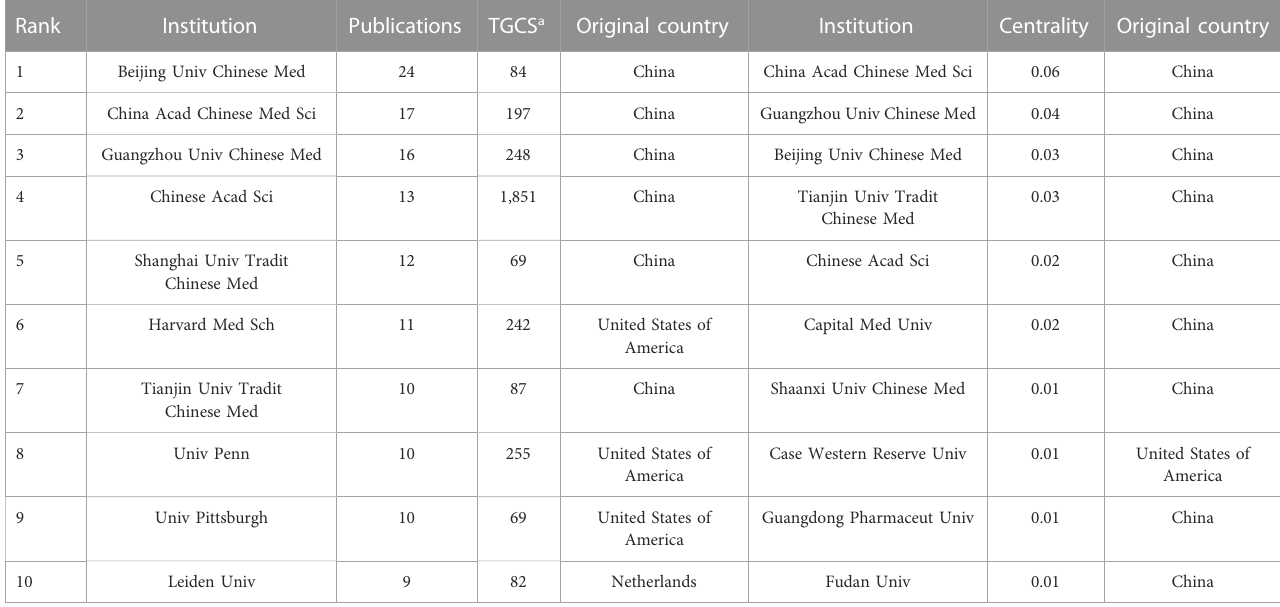
TABLE 2 Top 10 institutions distributed by publications and centrality.